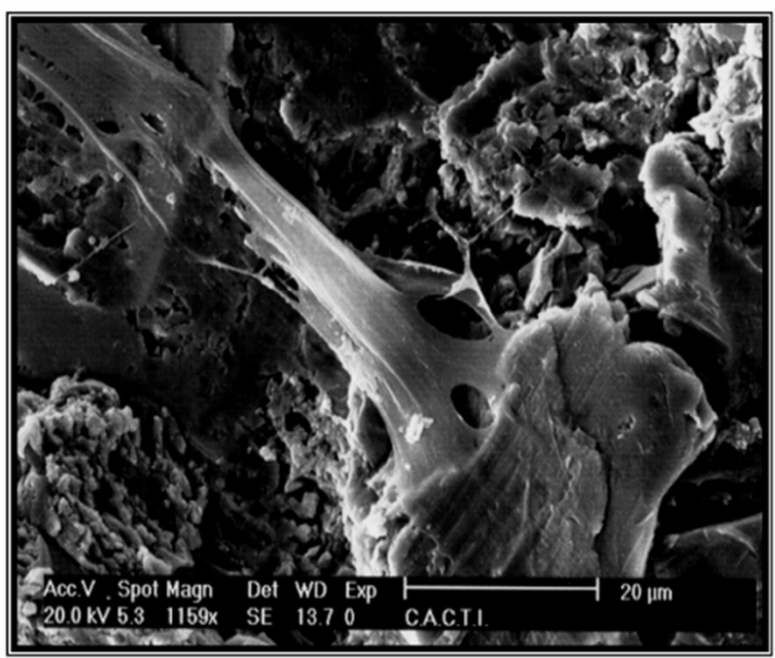
Figure 10. An osteoblast on the surface of sodium titanate with dorsal activity, which is the starting point of new bone